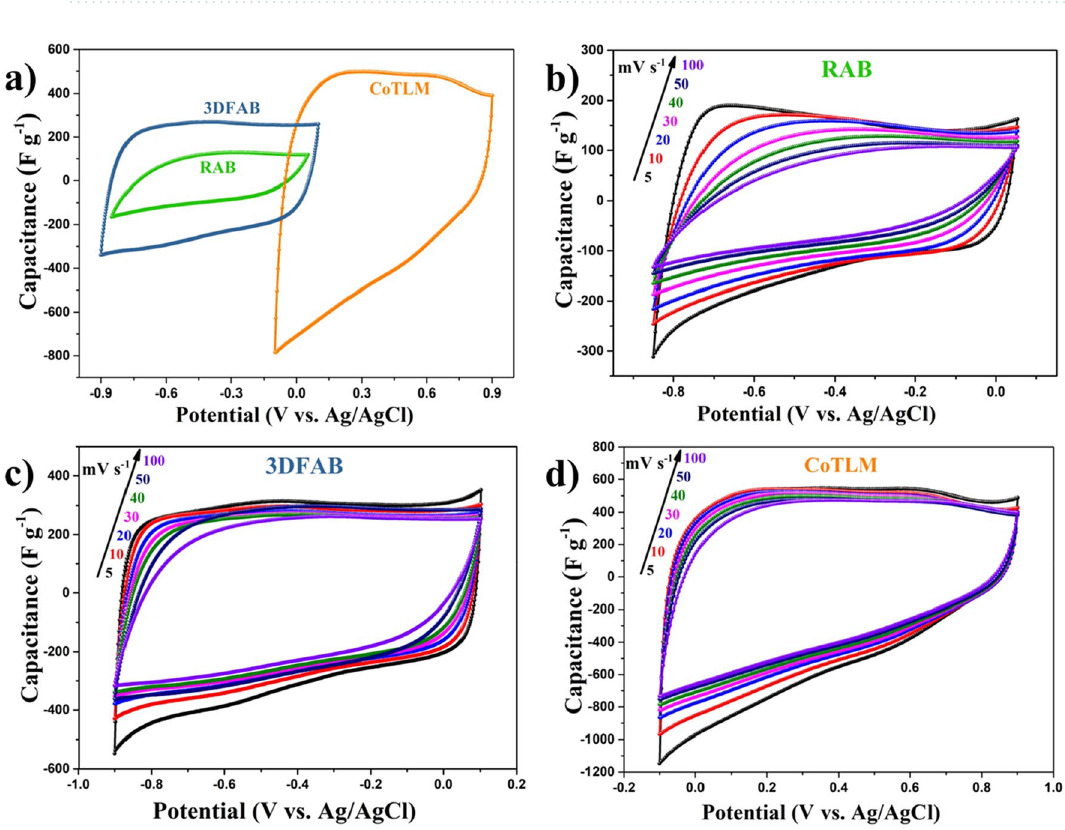
Figure 5. Electrochemical performance of the RAB, 3DFAB, and CoTLM electrodes. Cyclic voltammograms at 50 mV s −1 ( a ); cyclic voltammograms RAB, 3DFAB, and CoTLM at increasing rates from 5 to 100 mV s −1 ( b – d